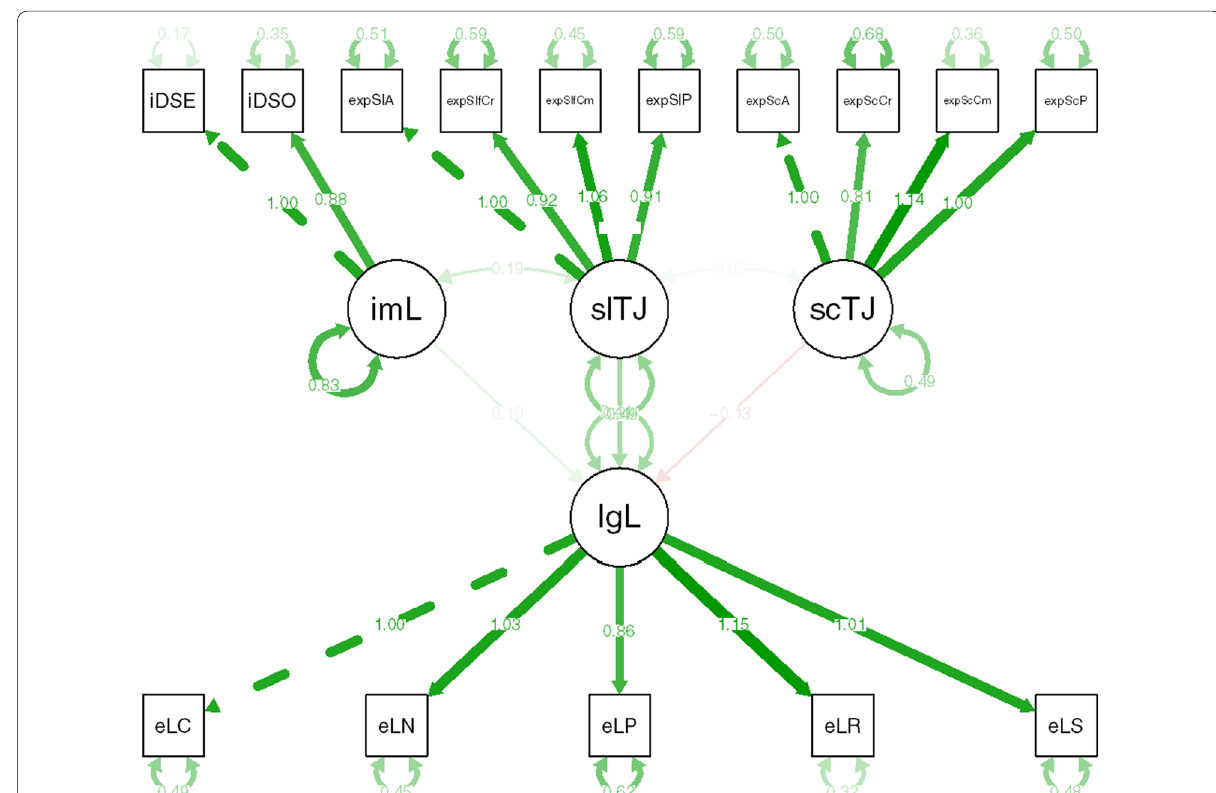
Fig. 1 Structural equation model (Study 2) in which a latent legal judgment variable [lgL] is predicted by a latent implicit hair attitude variable [imL], a latent self trait judgment variable [slTJ], and a latent societal trait judgment variable